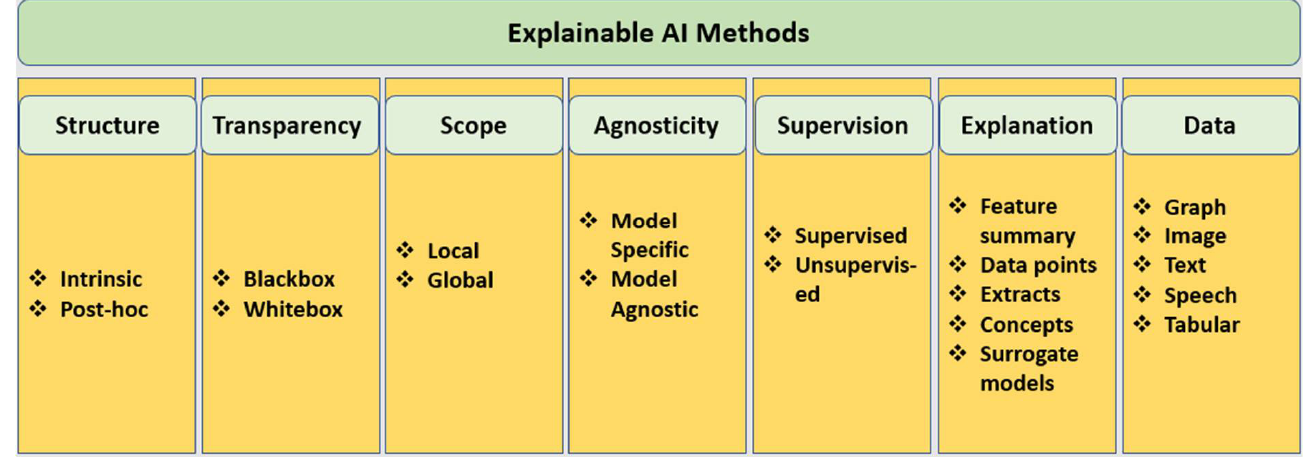
Figure 1. The figure lists various explainable AI methods.